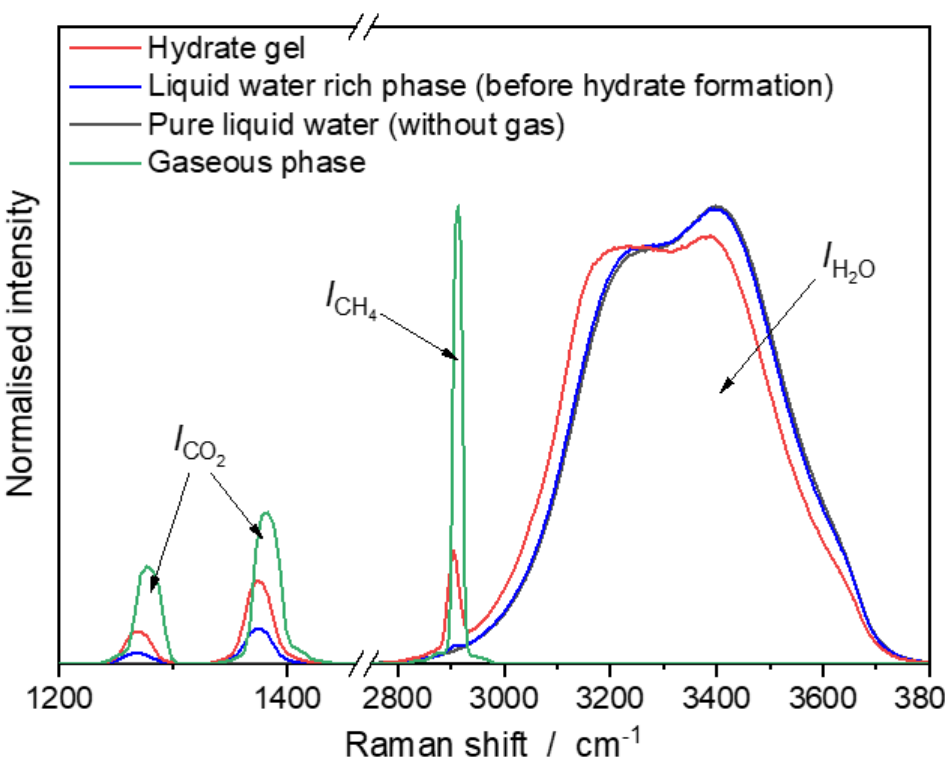
Figure 3. Example Raman spectra of the liquid water-rich phase at instant t 1 (see Figure 2), the hydrate gel at instant t 2 (see Figure 2), the gaseous CH 4 / CO 2 -mixture at instant t 0 (see Figure 2), and pure liquid water at T = 276.1 K. (For the pure liquid water spectrum, the pressure is p = 0.1 MPa ).